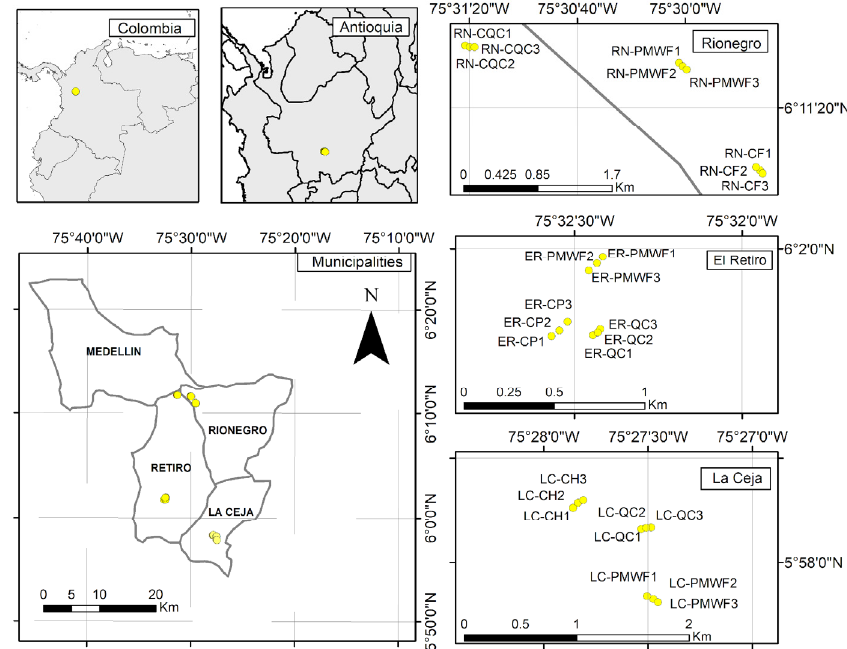
Figure 5. Geolocation of 27 soil samples retrieved in El Retiro-Pre-montane wet forest (ER-PMWF); La Ceja-Pre-montane wet forest (LC-PMWF); Rionegro-Pre-montane wet forest (RN-PMWF); El Retiro-Forestry crops of Pinus sp. (ER-CP); La Ceja-Crops of Hydrangea sp. (LC-CH); Rionegro-Crops of Fragaria ananassa (RN-CF); El Retiro-Quarry clays (ER-QC); La Ceja-Quarry clays (LC-QC); Rionegro-Closed quarry clays (RN-CQC) [45].